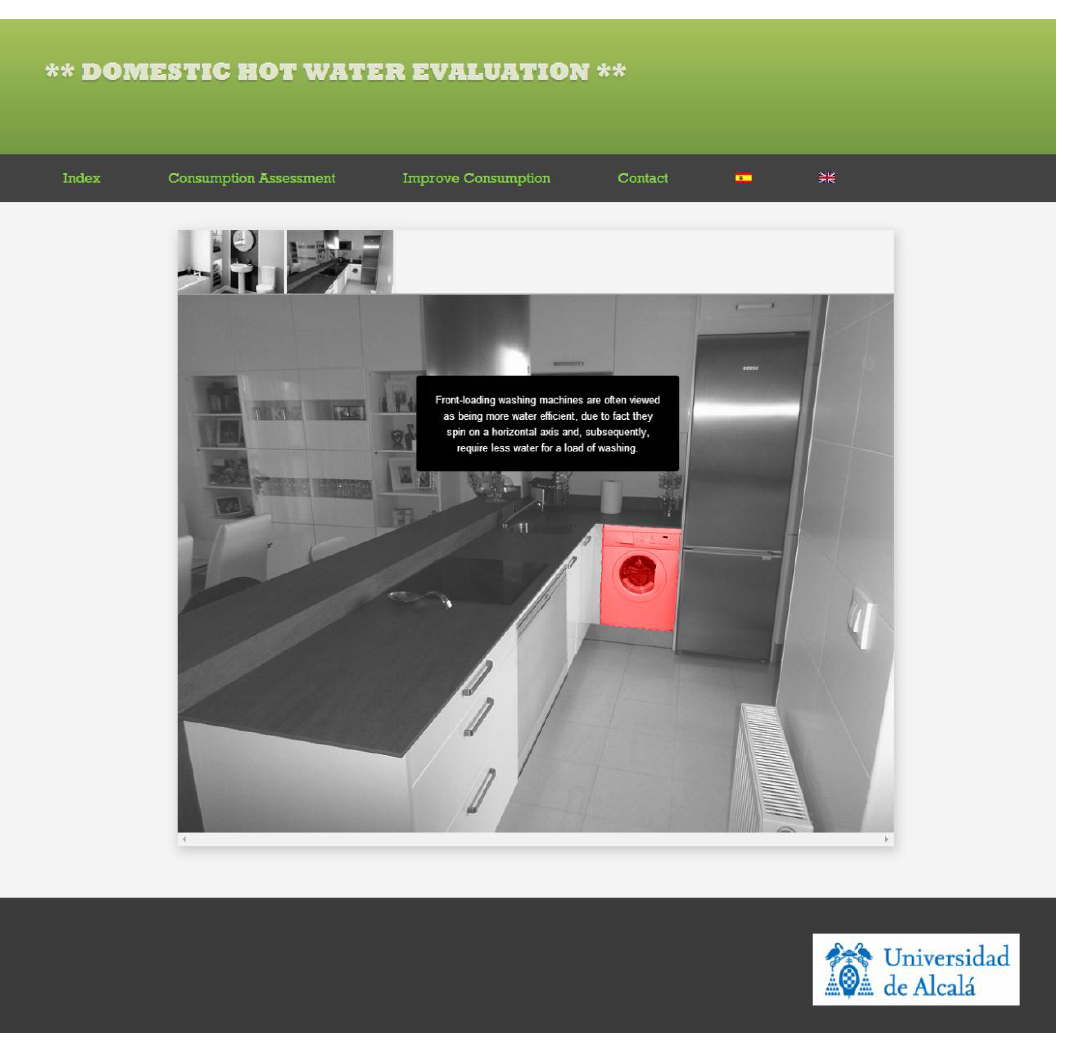
Figure 8. Piece of advice to reduce the energy consumption in